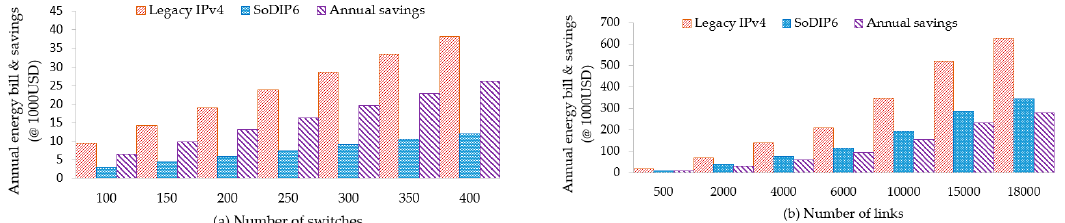
Figure 6. Comparative charts showing the estimated annual energy bill amount by both